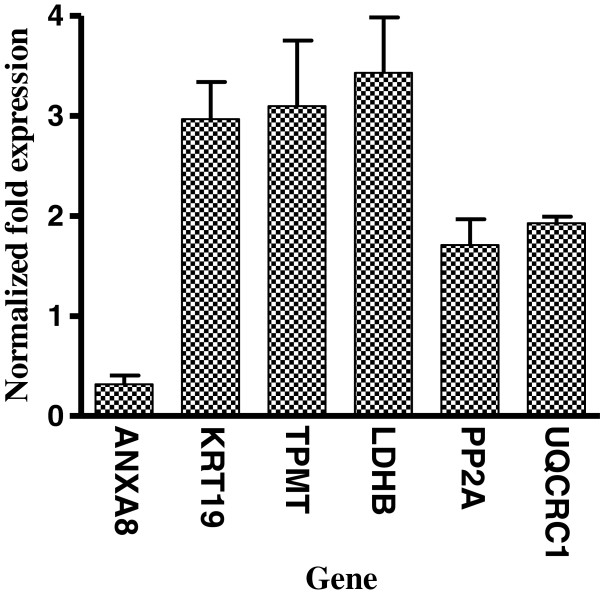
Transcript alteration of the differentially expressed proteins in TGEV-infected ST cells. Total cellular RNA of ST cells with or without TGEV infection at 48 h p.i. was measured by real time RT-PCR analysis. Samples were normalized with GAPDH gene as a control housekeeping gene. Error bars represent standard deviation. Gene symbols indicating different genes refer to Table 1 or Table 2.